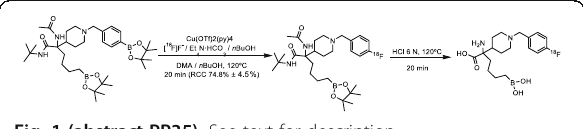
Fig. 1 (abstract PP35). See text for